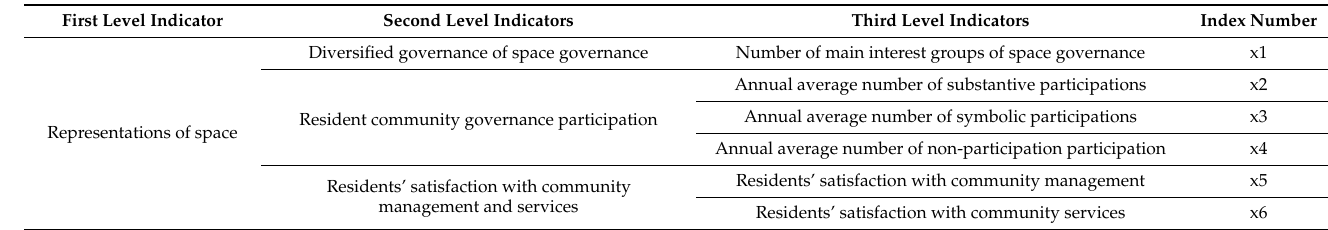
Table 1. Ternary space evaluation